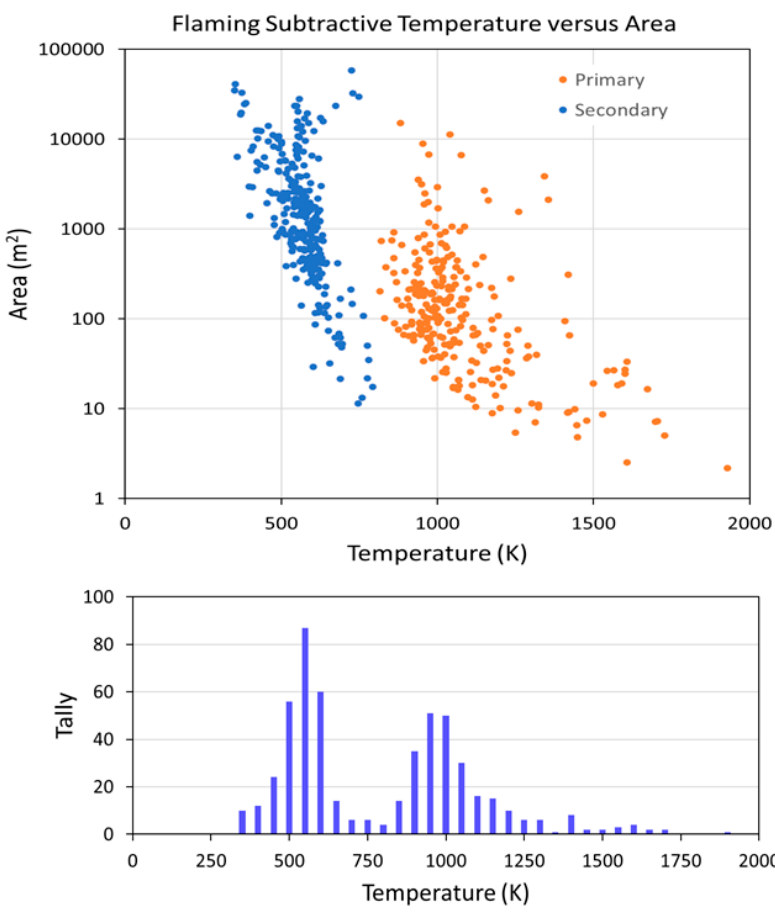
Figure 17. Flaming subtractive temperature versus area scattergram and temperature histogram for the Type 4 detections from the three test sites.